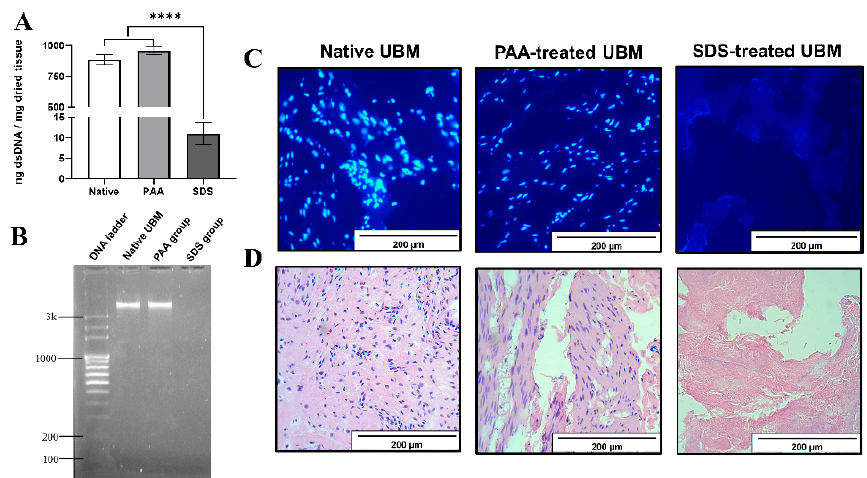
Figure 1. Decellularization e ffi ciency. ( A ) dsDNA content by Picogreen assay. **** denotes a statistically significant di ff erence ( p < 0.0001). ( B ) DNA fragment length quantification by electrophoresis. ( C ) DAPI (6-diamidino-2-phenylindole) stain (scale bars: 200 µ m). ( D ) Hematoxylin and eosin (HE) stain (scale bars: 200 µ m).